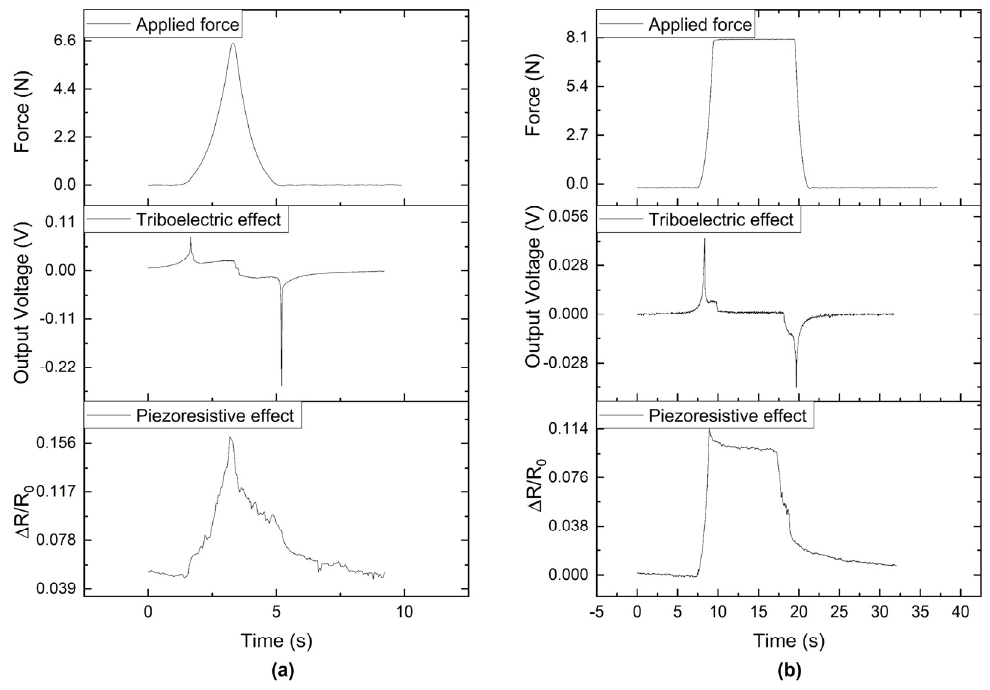
Figure 16. Piezoresistive and triboelectric effects under a deformation force for the nanocomposite prepared with the parallel lines magnetic pattern. ( a ) 0.5 wt%. of MWCNT/PDMS under a peak force of 6.6 N ( b ) 1 wt%. Of MWCNT/PDMS sample under a force of 8.1 N for 10 s.